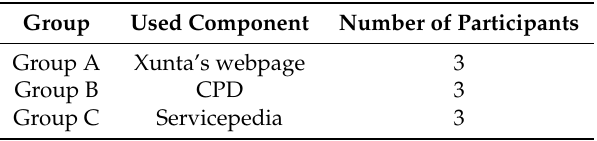
Table 2. Experiment